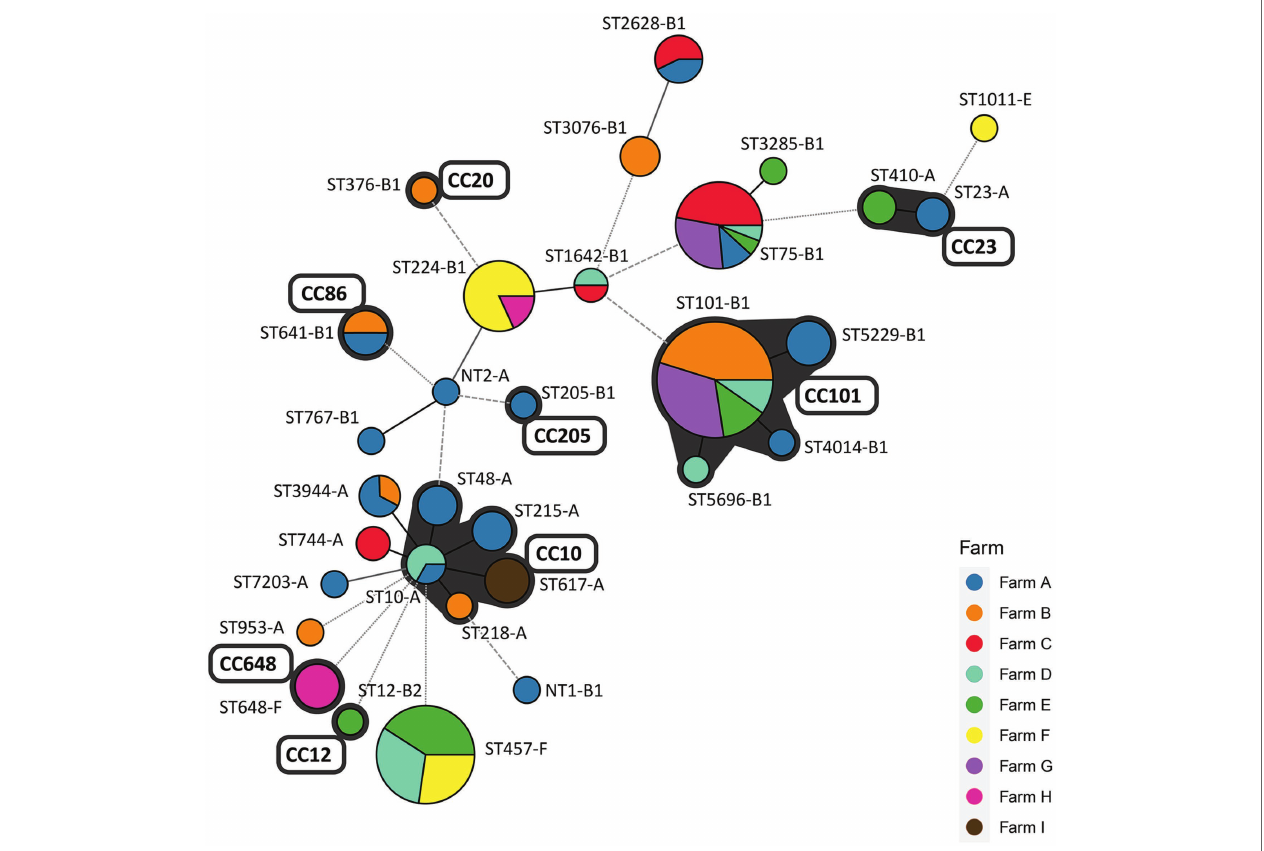
FIGURE 5 | Minimum spanning tree (MST) based on allele profiles of multi-locus sequence type (MLST): clonal distribution of ESBL/AmpC-EC between pig farms. The number shows the sequence type of each node, and the size of the node indicates the number of strains belonging to the sequence type (ST)-phylogenetic group. The gray shadow represents the clonal complex (CC). Branch line types represent differences in the number of alleles: bold solid line (1 allele), thin solid line (2–3 alleles), dashed line (4 alleles), and dotted line (above 5 alleles). CC, clonal complex; ST, sequence type; NT, non-typable ST (including two different non-typable